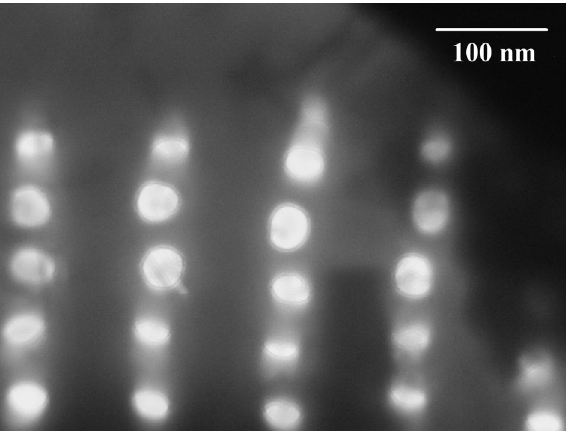
Figure 4: TEM image of the pristine diatomite sample